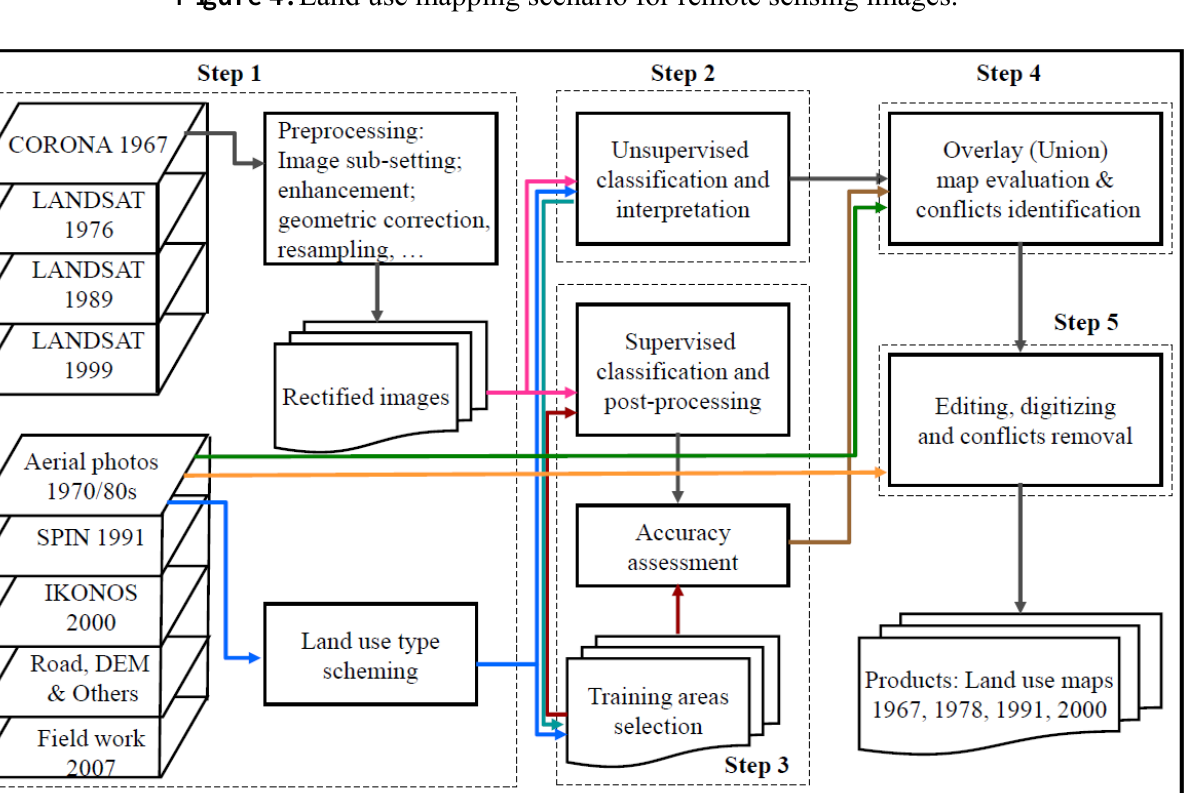
Figure 4. Land use mapping scenario for remote sensing